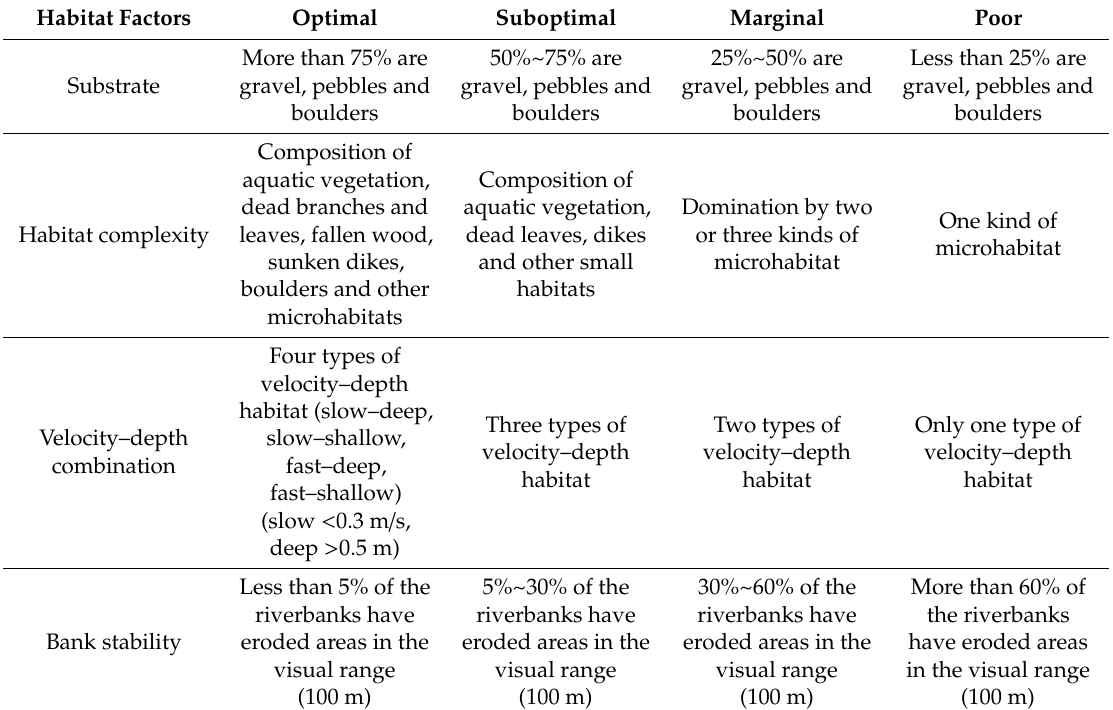
Table A1. Habitat assessment scoring descriptions in Liao River